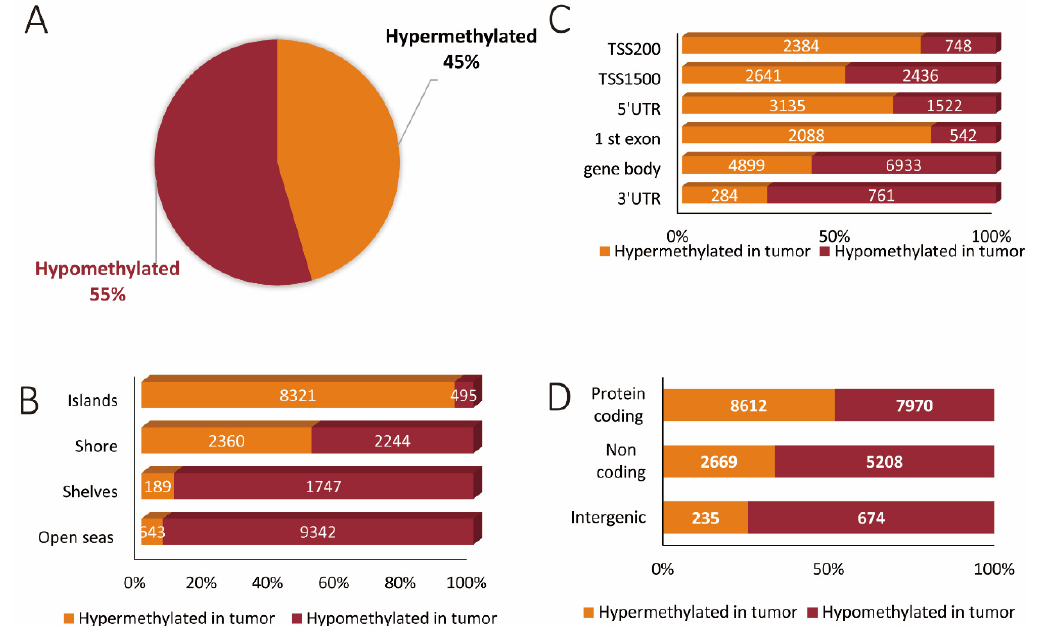
Figure 2. The methylation landscape of all genes across genomic features relative to hypermethylated and hypomethylated states. ( A ) Relative contribution of unique hypermethylated and hypomethylated CpG sites. ( B ) Percentages of CpG hypermethylation and hypomethylation events according to their CpG content and neighborhood context. ( C ) The distribution of hypermethylated and hypomethylated CpGs examined in different functional genomic regions. ( D ) The differentially methylated sites within protein-coding genes, non-coding genes, and intergenic regions.